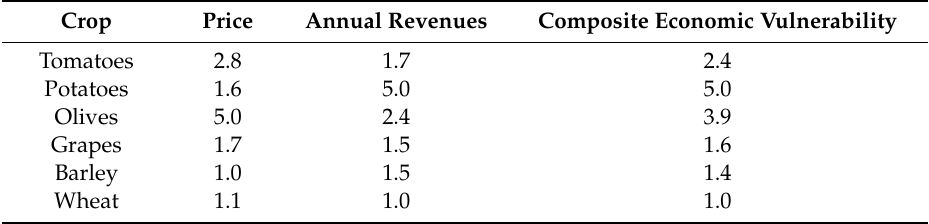
Table 11. Economic vulnerability scores for each crop